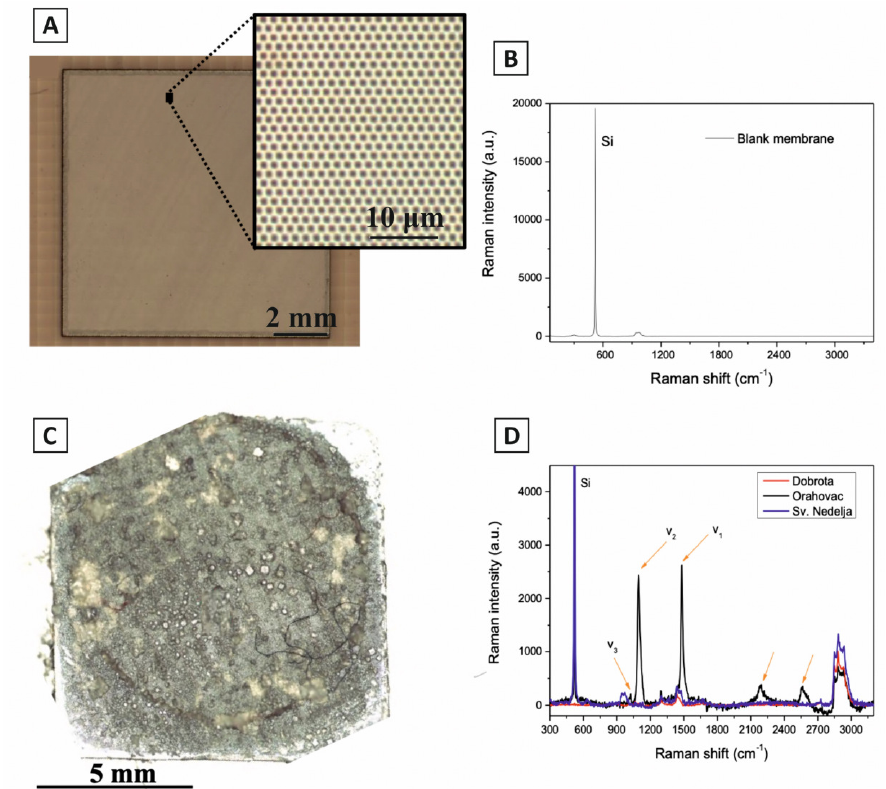
Figure 3. ( A ) Image of the blank silicon membrane and a zoomed image of its periodic microstructure ( B ) Raman spectrum of the blank silicon microfilter membrane. ( C ) Optical micrograph collected with a 10 × objective of one of the membranes prepared from the Dobrota sample. ( D ) Spectra of the organic background present on the surface of the membranes realized by filtering samples from all three sampling